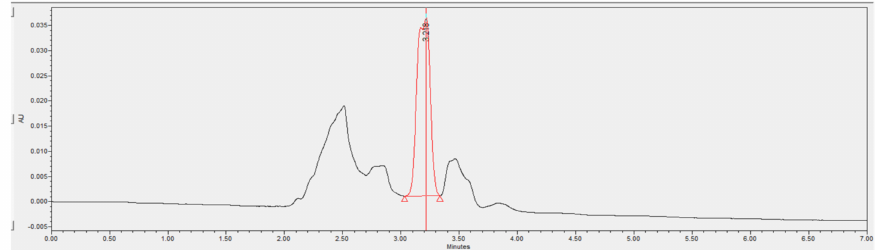
Figure 14. Chromatogram of a phenol containing wastewater sample after being treated with A2O-MBBR